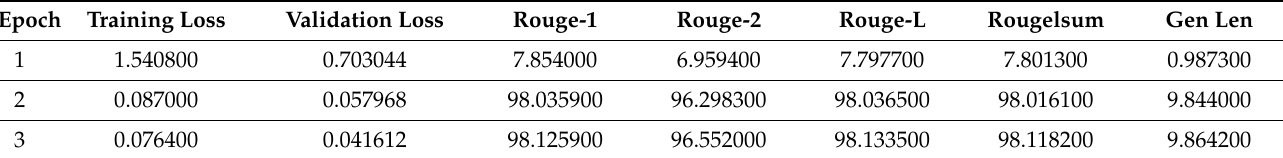
Table 7. Training process and results of Q2S after augmentation (on MEDIQA-2019).